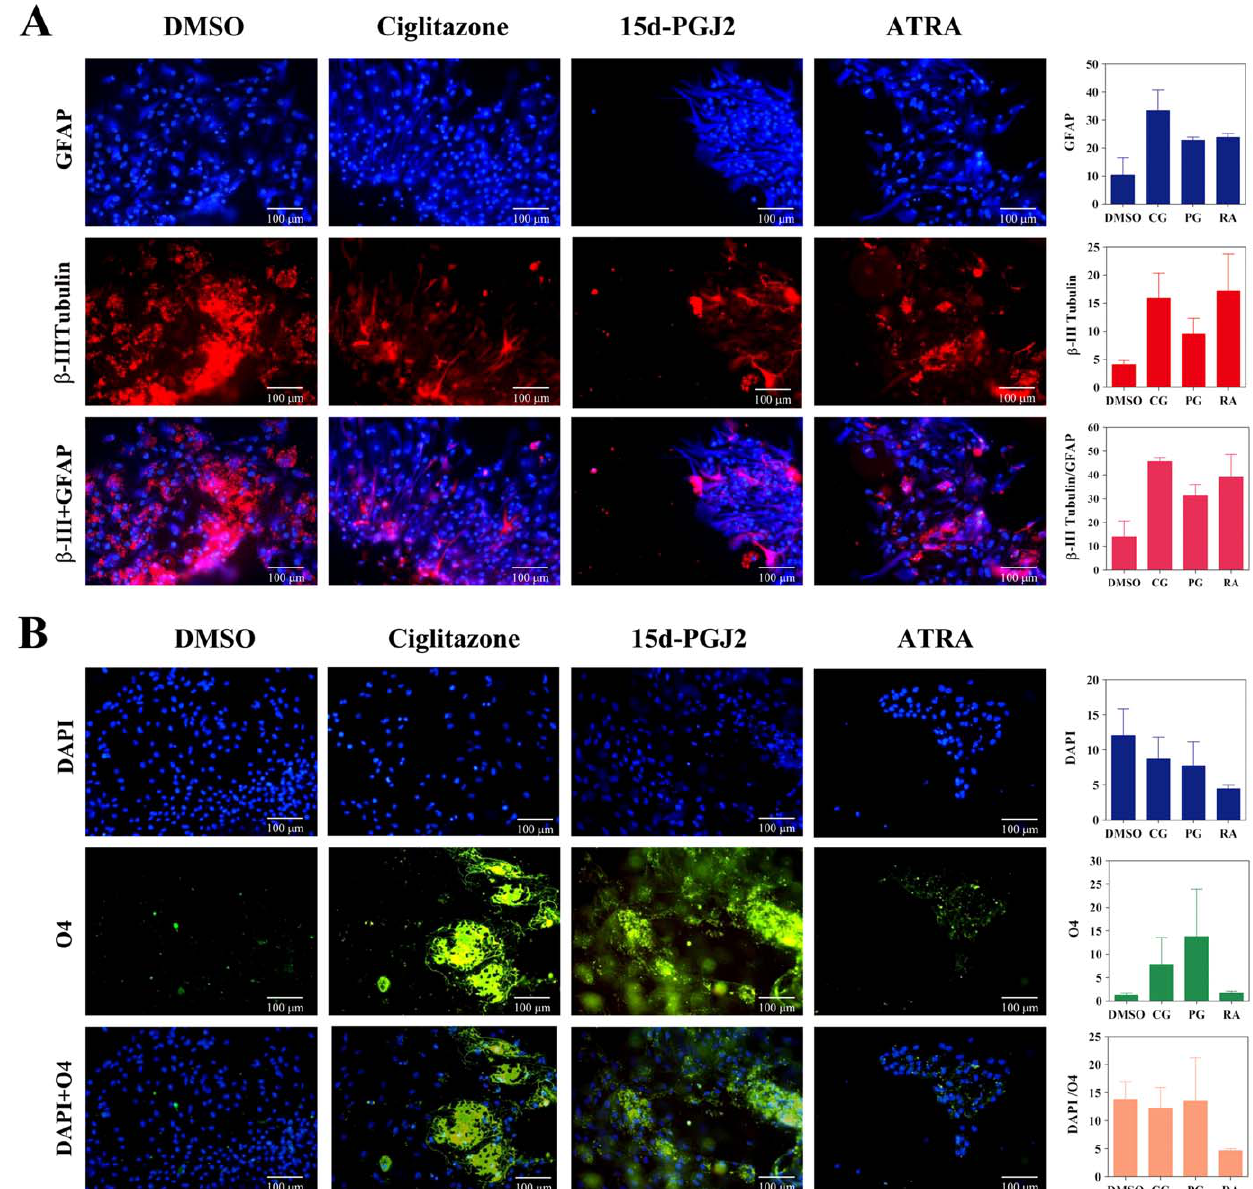
Figure 4. PPAR c agonists induce the expression of oligodendrocyte markers in three days in NSCs. Neurospheres were cultured in poly- D-lysine coated 8 well chamber slides in NBM + B27 with 10 ng/ml EGF + bFGF in the presence of 0 (DMSO) or 1 m M ciglitazone, 15d-PGJ2 or ATRA. After 3 days the cells were stained with GFAP, b III tubulin, and O4 antibodies along with DAPI and photographed (200 6 ) under fluorescence microscope. The figure is a representative of three independent experiments. The values are mean 6 SEM and the p values are expressed as *(p , 0.05), **(p , 0.01), and ***(p , 0.001). The figure is a representative of three independent experiments.